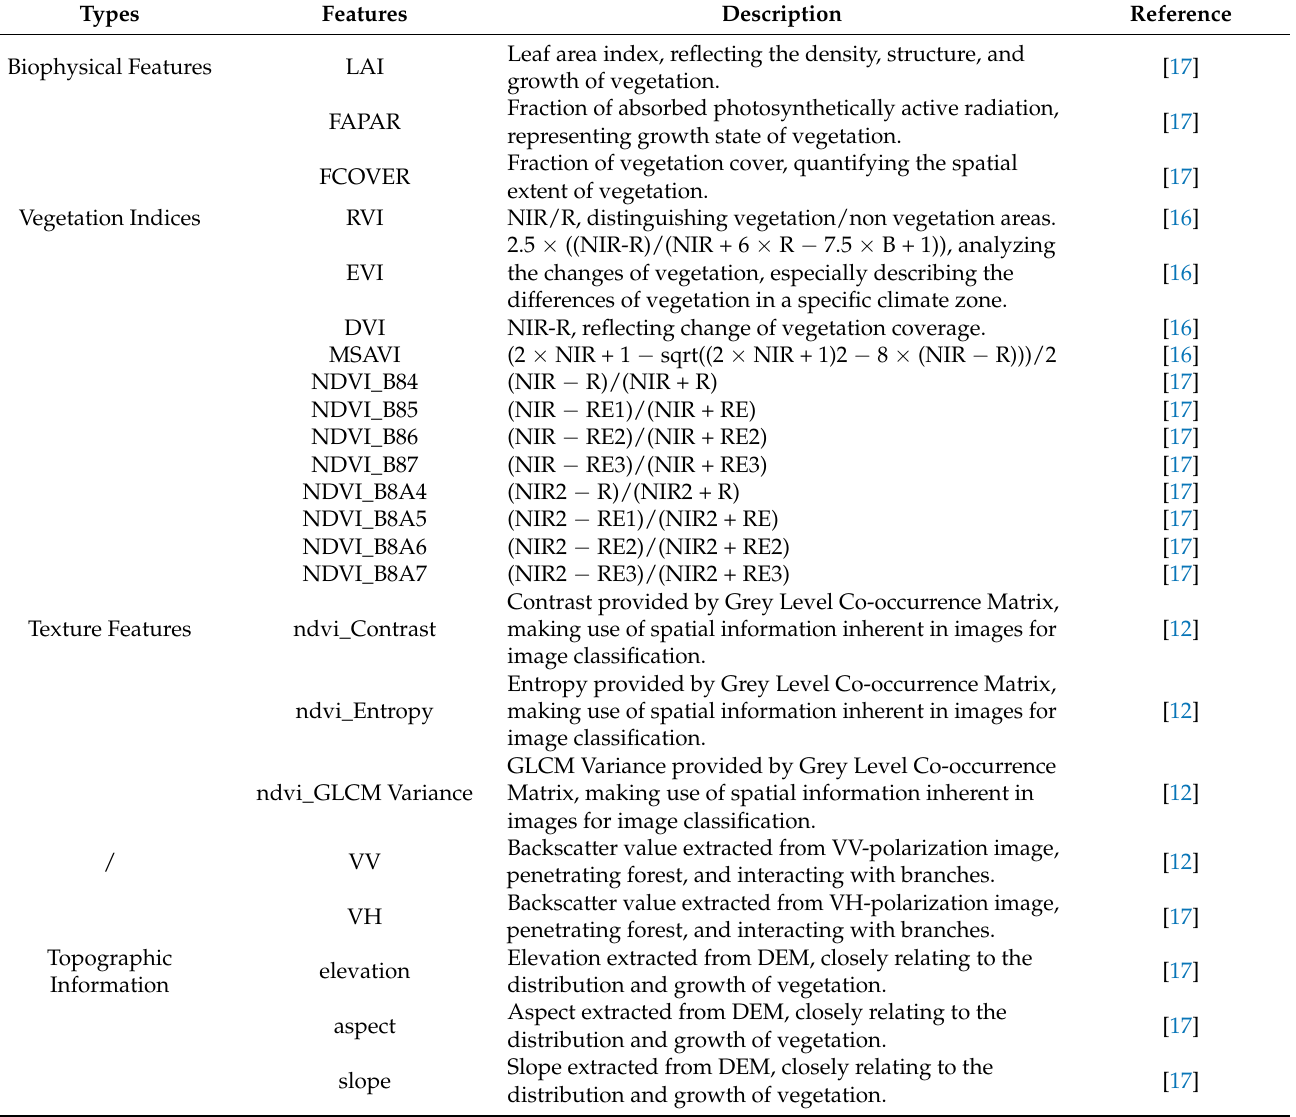
Table 2. Independent variables selected for the modelling process. (The first, second, and third columns correspond to the category, name, and explanation of the